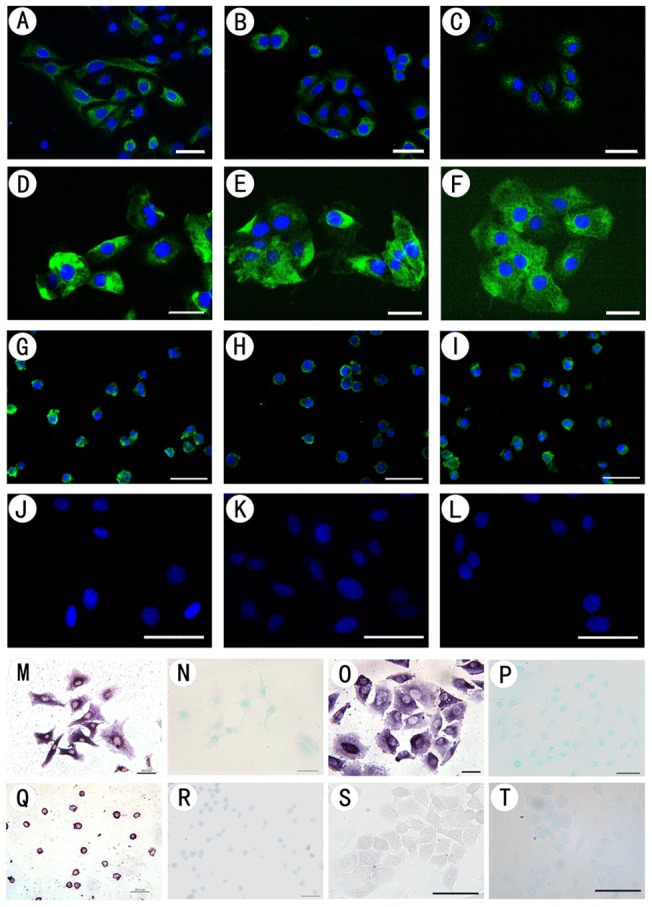
IgG expression in lung cancer cell lines with ISH and immunofluorescence.
A–C, Igγ (A), Igκ (B) and Igλ (C) are expressed in A549 cells with immunofluorescence. D–F, Igγ (D), Igκ (E) and Igλ (F) are expressed in SK-MES-1 cells. G–I, Igγ (G), Igκ (H) and Igλ (I) are in Raji cells as positive control. J–L, Igγ (J), Igκ (K) and Igλ (L) are not expressed in Beas2B cells. Positive signals (purple) for IGHG1 antisense probe are seen in the cytoplasm of A549 (M), SK-MES-1 (O) and Raji (Q) cells. N, P and R show negative results (sense probe) in A549, SK-MES-1 and Raji cells. No positive signals are found in Beas2B cells (S, the antisense probe; and T, the sense probe). To highlight the cells without purple signal, methyl green was use to counterstain the nuclei. Scale bars: 20 µm.